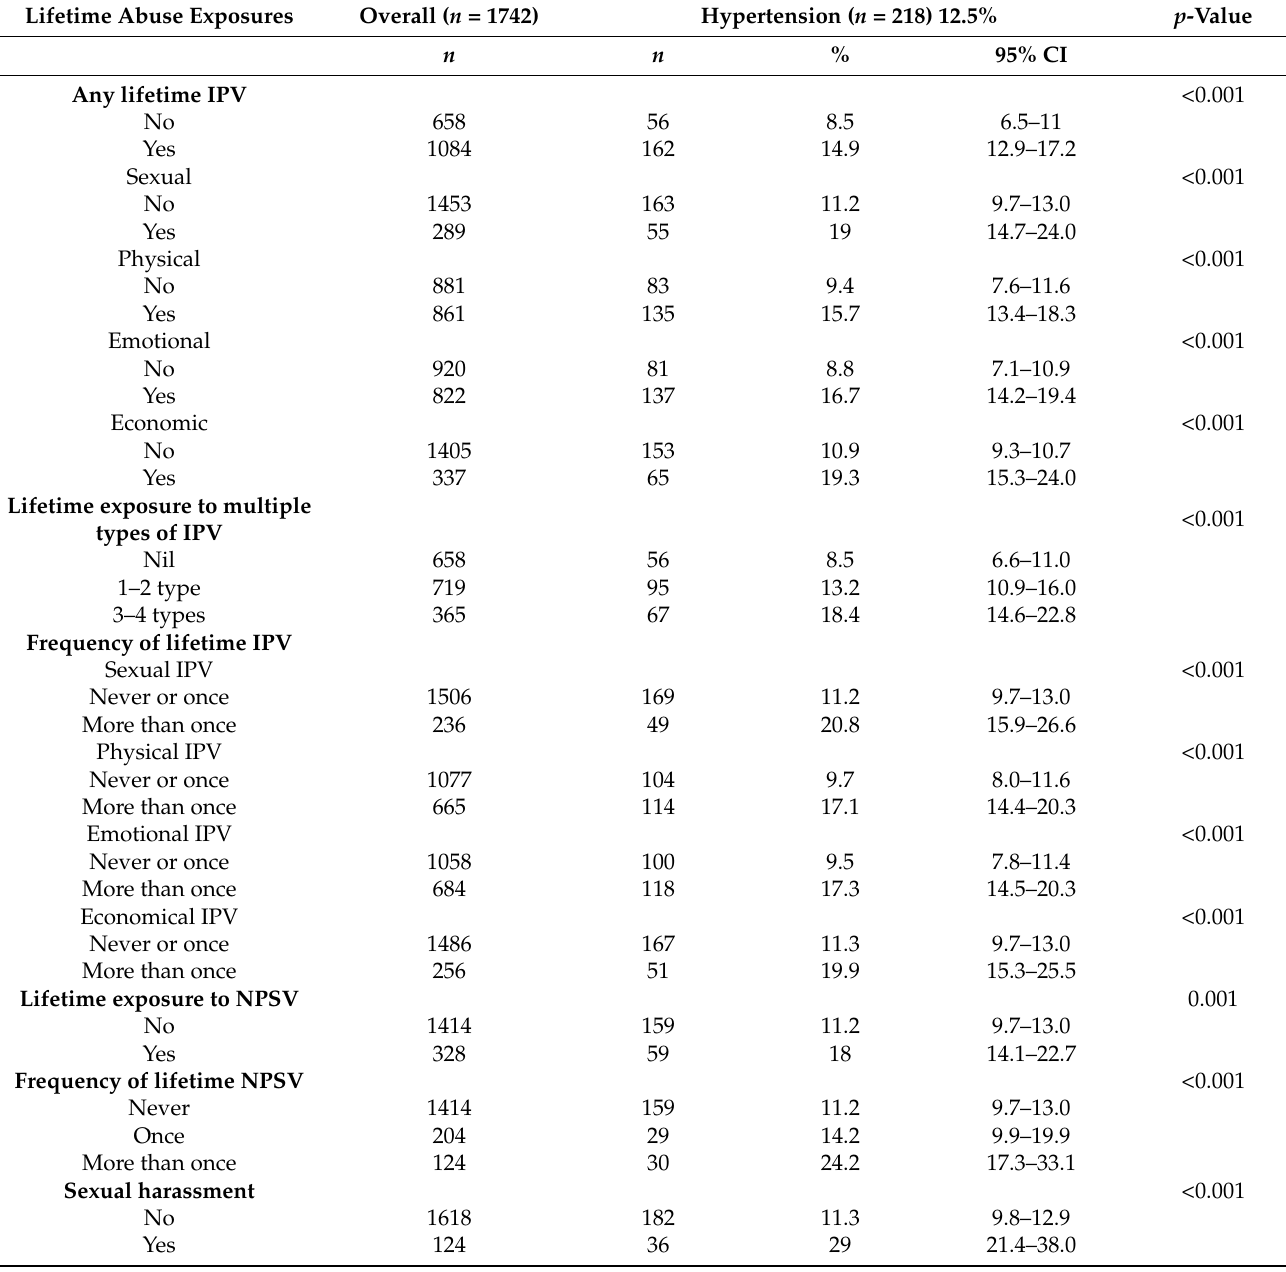
Table 1. Prevalence of hypertension by lifetime intimate partner violence, non-partner sexual violence and sexual